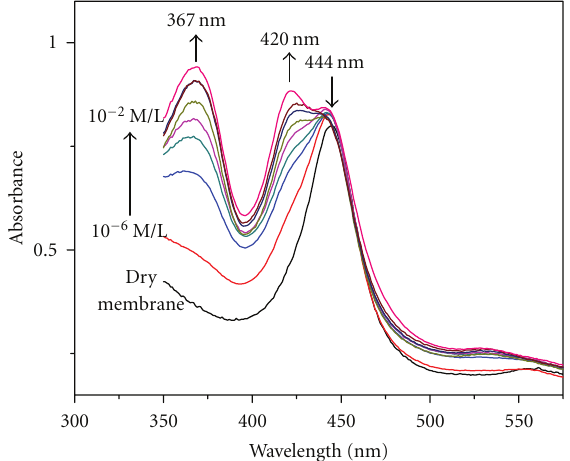
Figure 6: UV-visible spectra of dry membrane III and soaked in 10 − 6 –10 − 2 M/L solutions of NaHCO 3